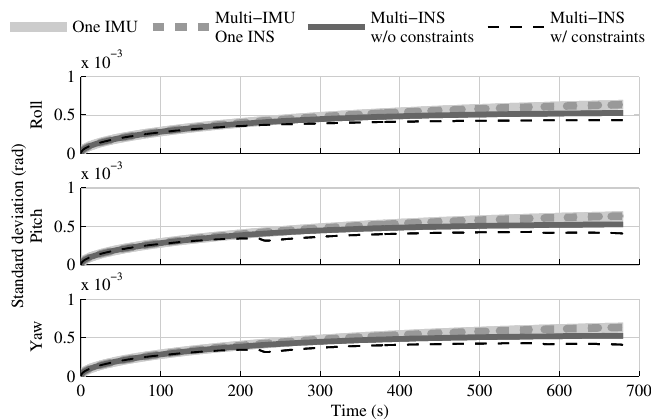
Figure 10. The attitude estimation error standard deviation obtained with the navigation solutions, when the GPS receiver is not present.